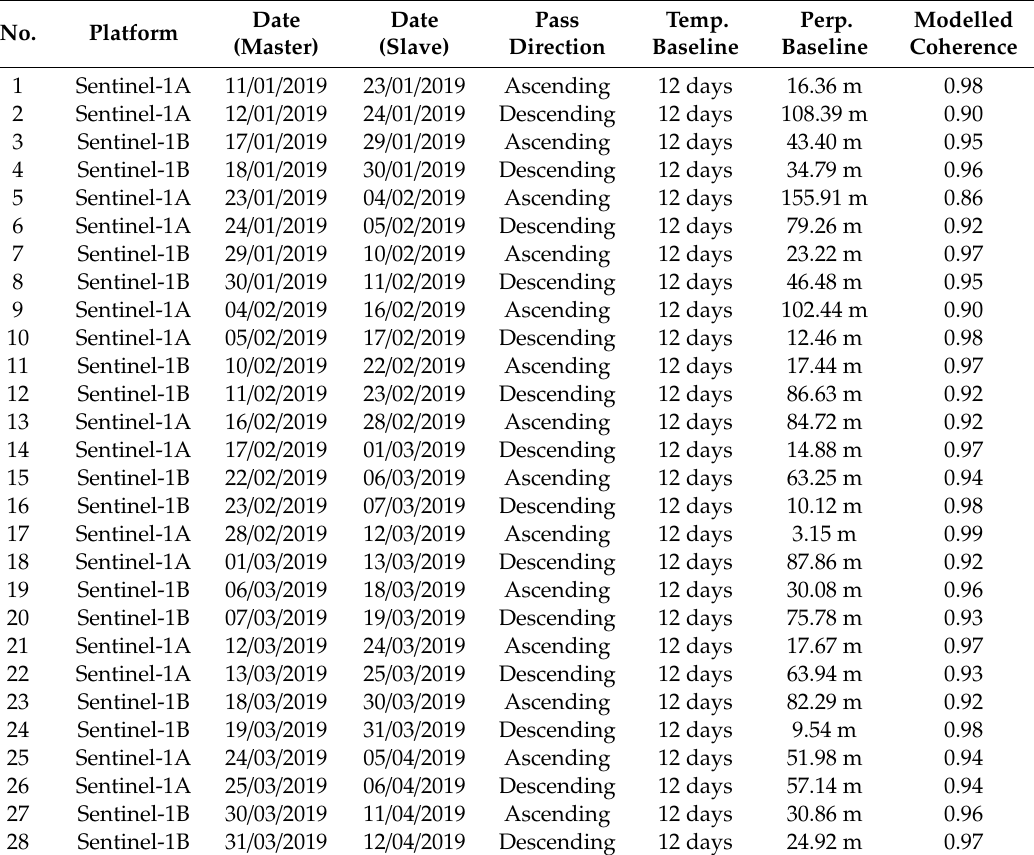
Table 1. Synthetic Aperture Radar (SAR) image interferometric